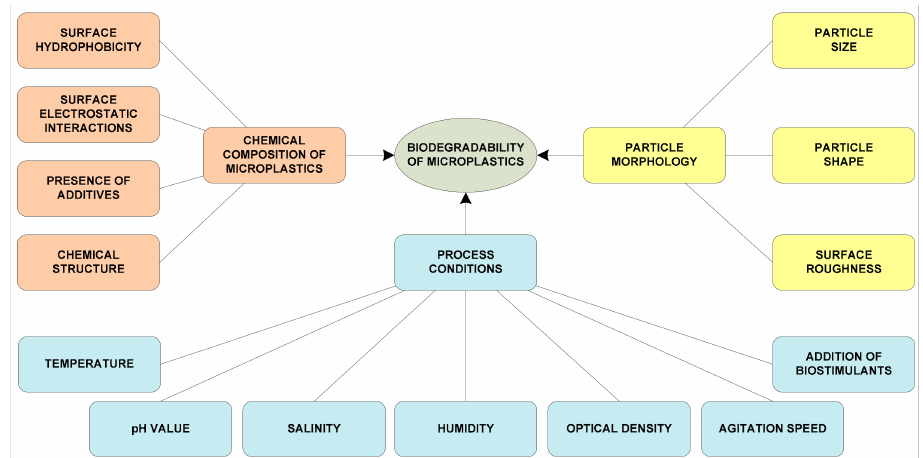
Figure 1. Factors affecting biodegradability of